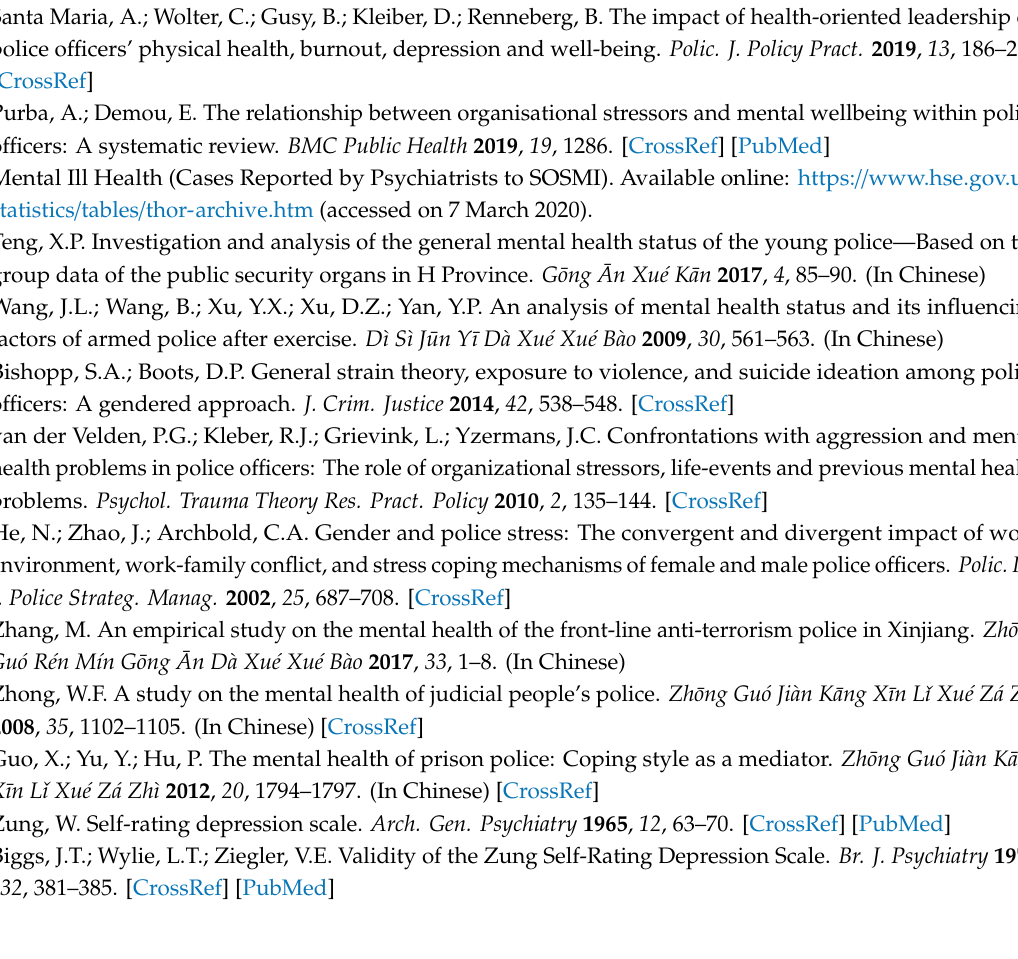
Supplementary Materials: The following are available online at http: // www.mdpi.com / 1660-4601 / 17 / 8 / 2737 / s1, Figure S1: Di ff erent factor structures of